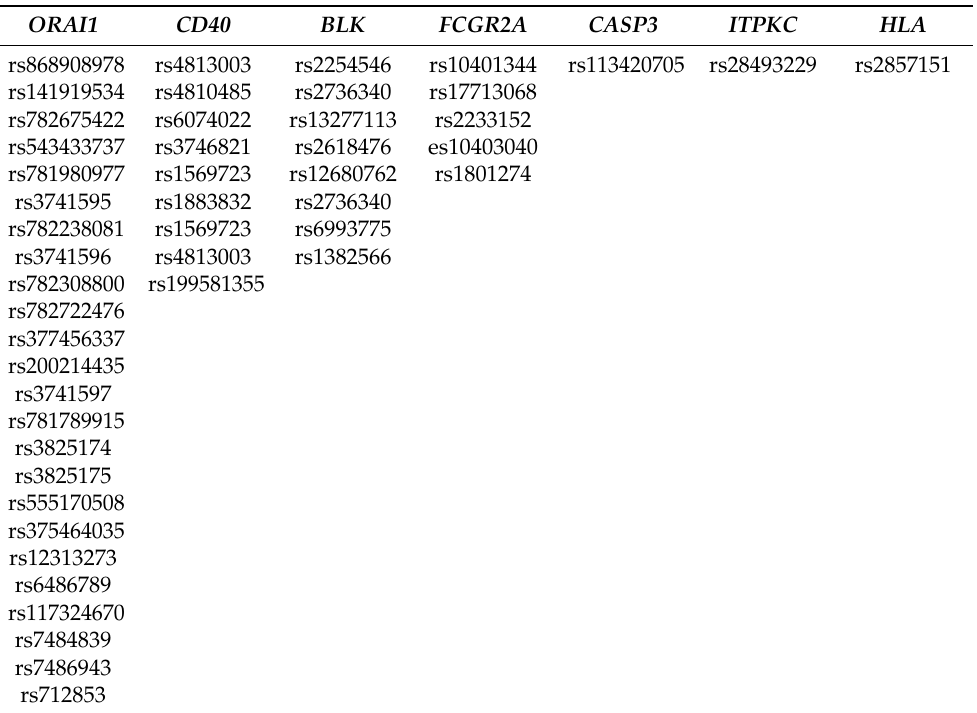
Table 2. Studied single-nucleotide variants in the candidate genes in Japanese Kawasaki